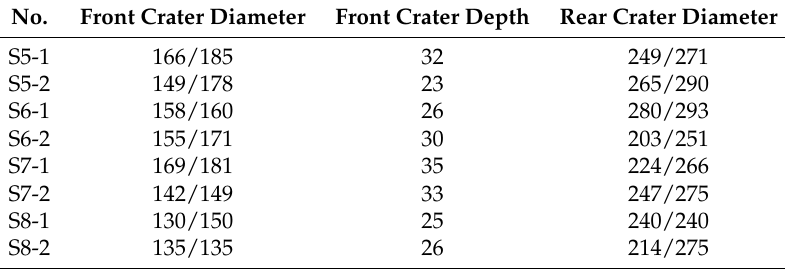
Table 5. Blast damage for PP-Steel HFRC panels (in